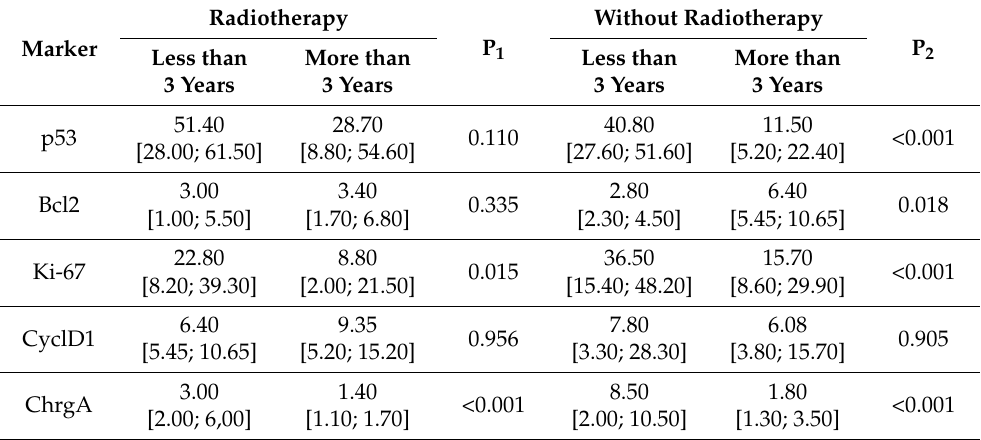
Table 3. Indicators of immunohistochemical markers in patients with and without preoperative radiotherapy (survival